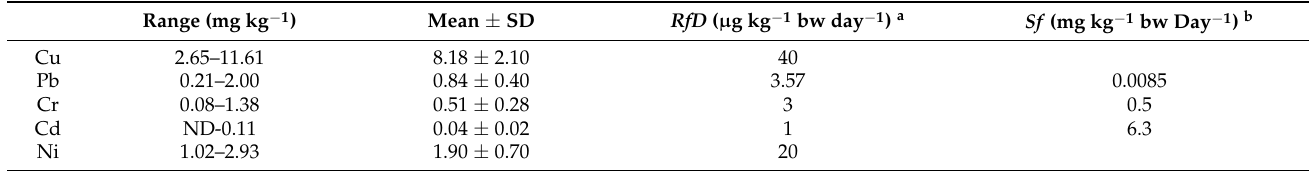
Table 4. The contamination levels, oral reference dose ( RfD ) values and slope factors ( Sf ) of five potentiality toxic elements